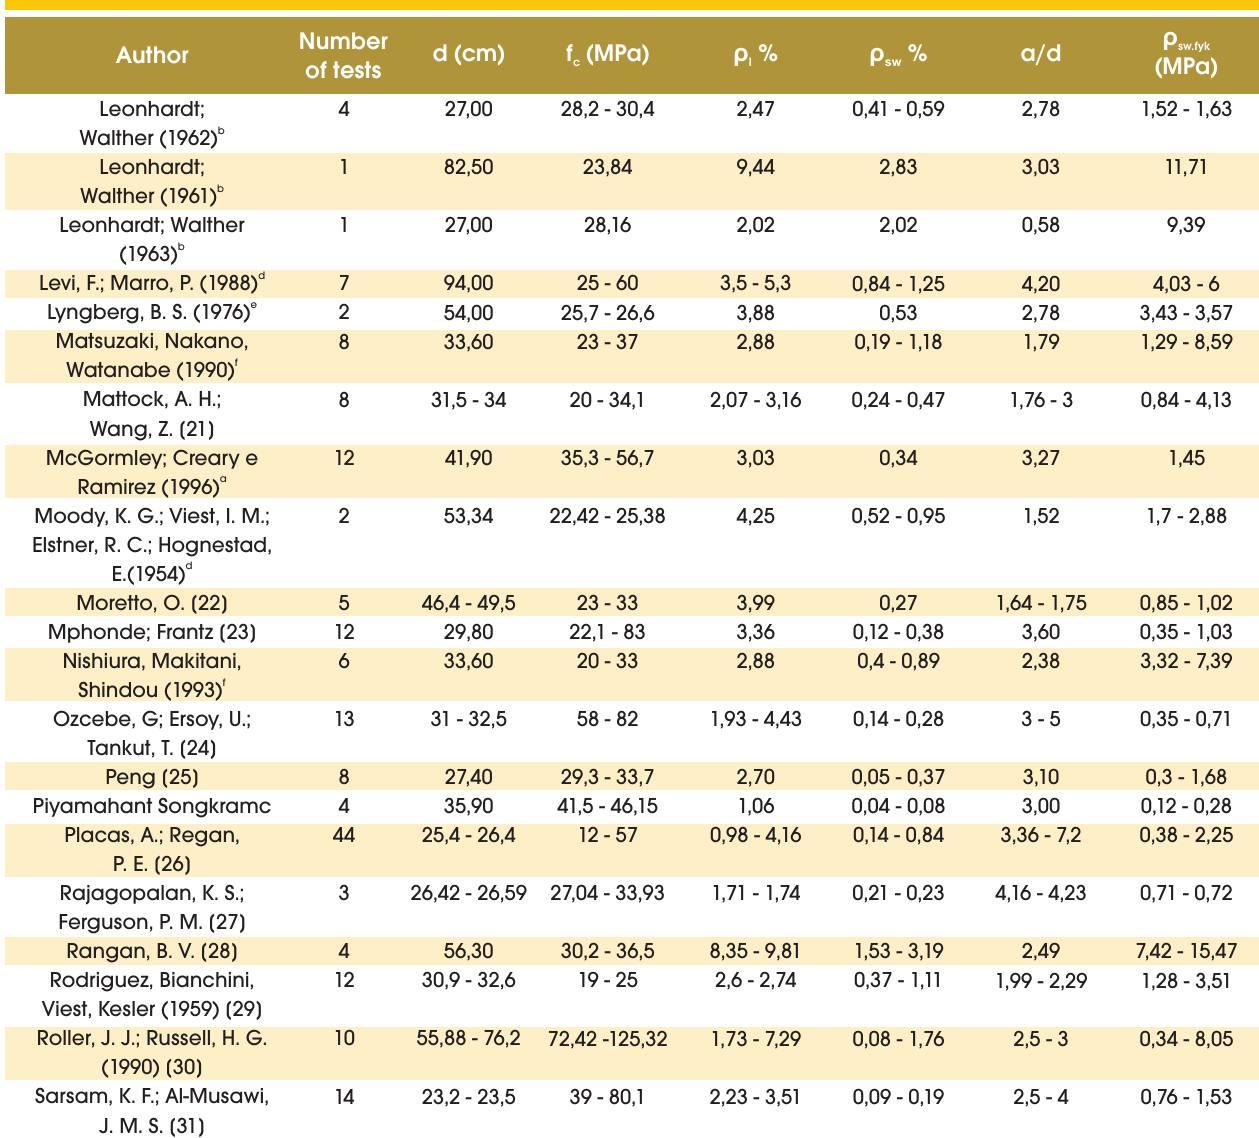
Table 2 – Database for RC beams with stirrups (part